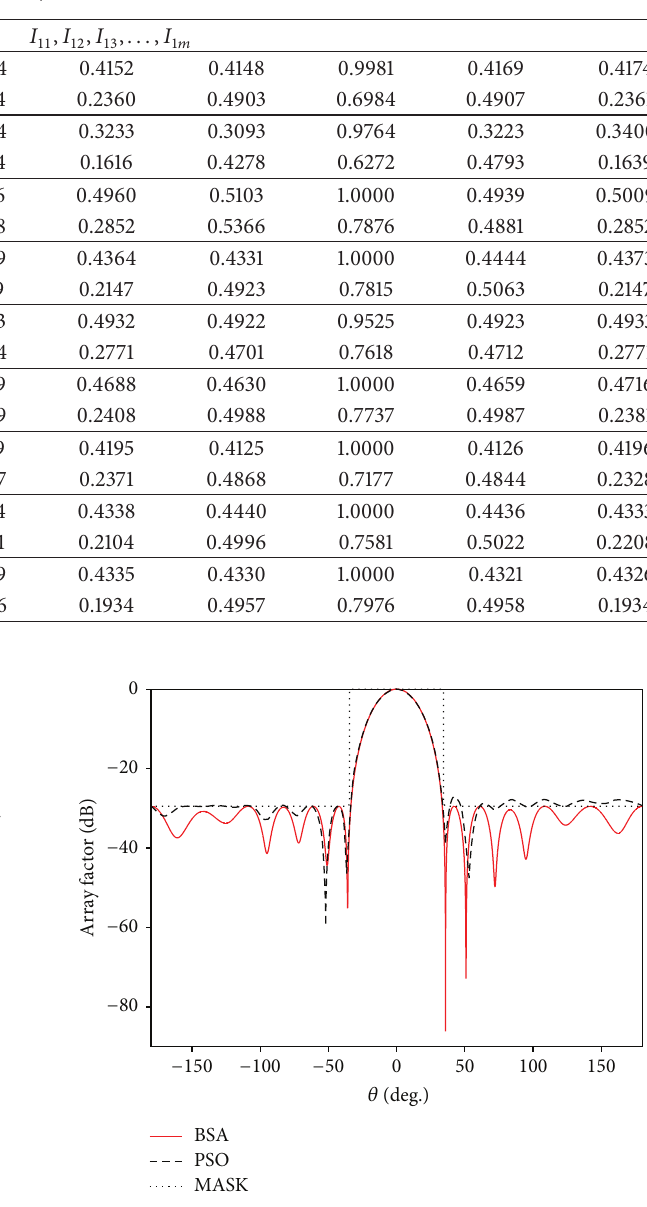
Figure 3: The radiation patterns obtained by BSA and EP [1] for CCAA without central element .